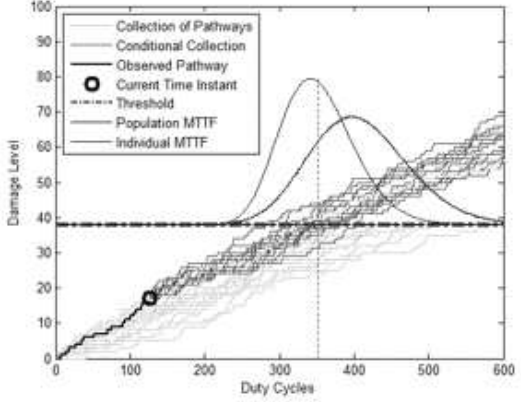
Fig. 4. Markov Chain Prognostic Model